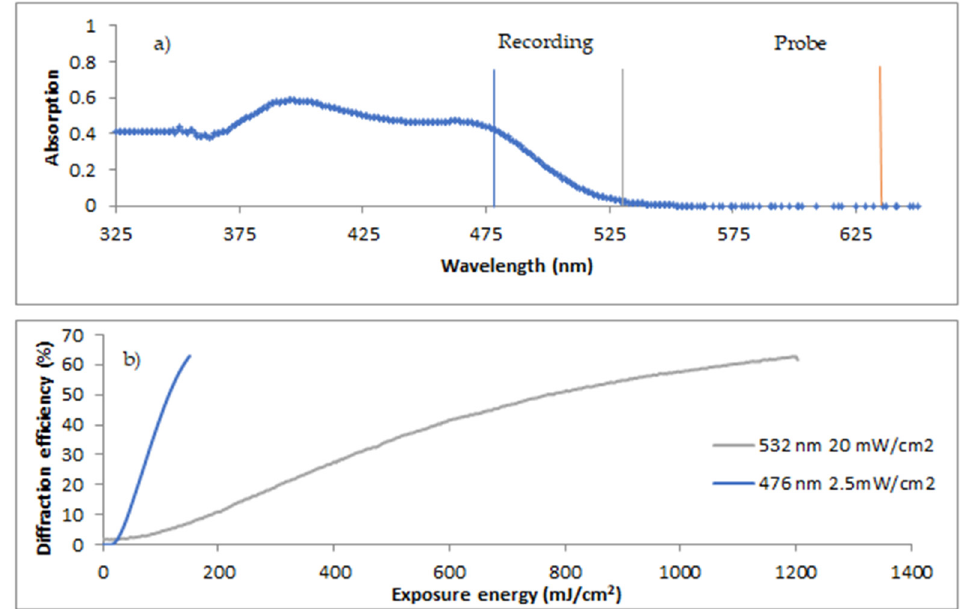
Figure 6. ( a ) UV–Vis spectrum of photosensitive sol–gel layers (after oven curing outlined in Figure 4) noting recording wavelengths of 532 and 476 nm, and probe wavelength of 633 nm; ( b ) diffraction efficiency growth curves of transmission gratings with the spatial frequency of 500 L/mm recorded at 532 nm and 476 nm with an intensity of 20 mW/cm 2 and 2.5 mW/cm 2 , respectively; thicknesses for blue and green recordings are 80 and 100 μ m, respectively.